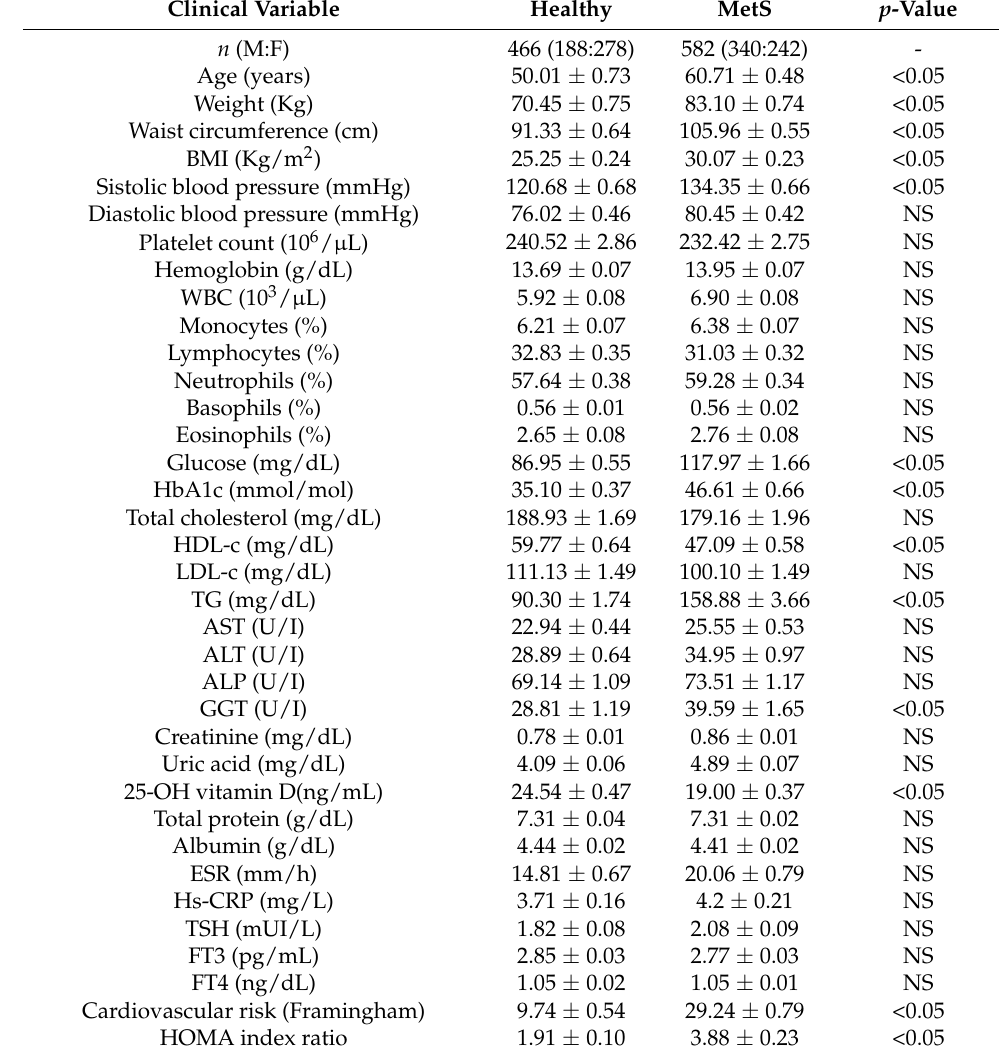
Table 1. Clinical characterization of the study population 1